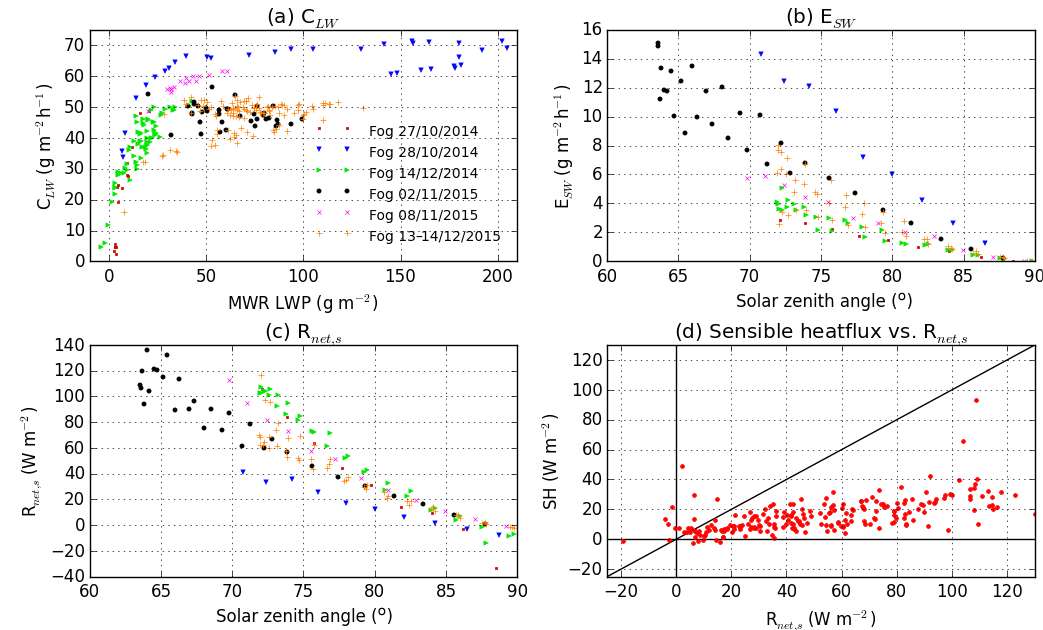
Figure 5. C LW (a) , E SW (b) and R net , s (c) (defined in Sect. 2.1), calculated every 15min from formation time to dissipation time for the six fog events without clouds above in Table 2. (d) Measured 10min average sensible heat flux at 2m vs. measured 10min average R net , s (at 10m) during the daytime fog hours of all fog events in Table 2, excluding 28 October 2014 because the measurements are